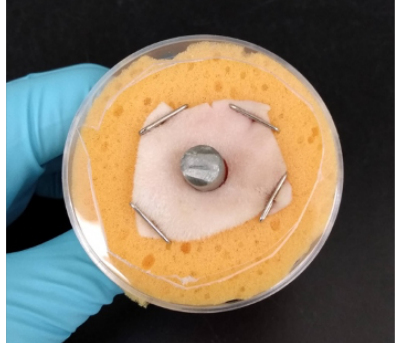
Figure 2. Example of assembled ex vivo model with Petri dish for structural